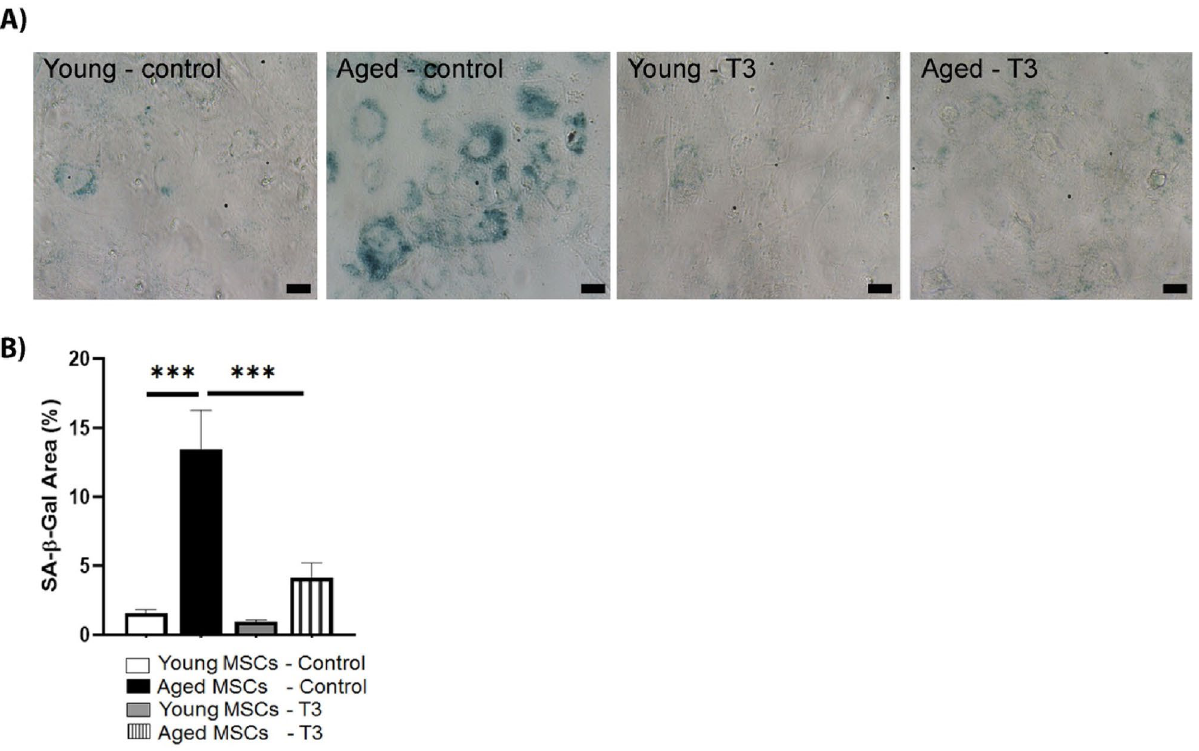
Figure 9. Effects of multiple doses of PBM on SA-β-Gal activity of young and aged MSCs. Young and aged MSCs underwent a PBM treatment at 3 J/cm 2 for 3 (T3) days in a row, while untreated MSCs served as controls. On day 7, the cells were fixed and subjected to SA-β-Gal staining. ( A ) Shown are representative images of senescent cells. Scale bars: 20 μm. ( B ) Shown are mean percentages of the SA-β-Gal-stained area for each group as a bar graph. The error bars represent the standard error of mean. *** p <